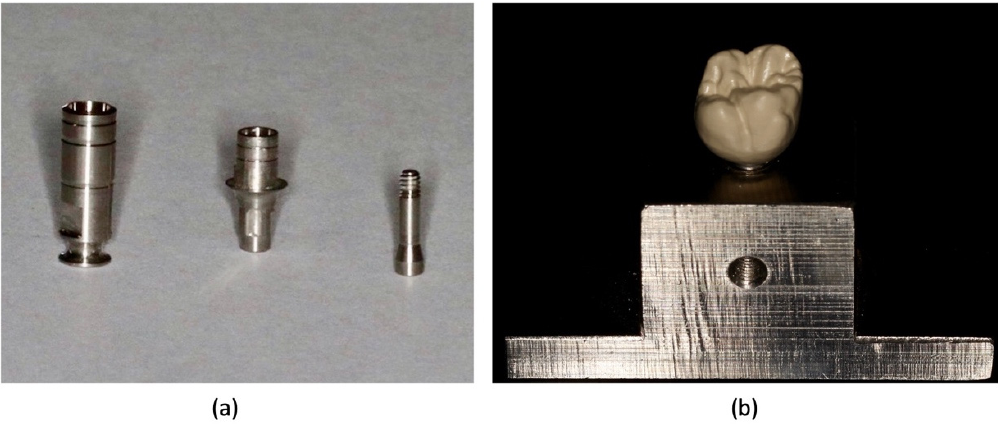
Figure 2. ( a ) Antirotational titanium temporary abutment, laboratory analogue, and screw; ( b ) CAD/CAM crown adapted to the load cell clamping table.